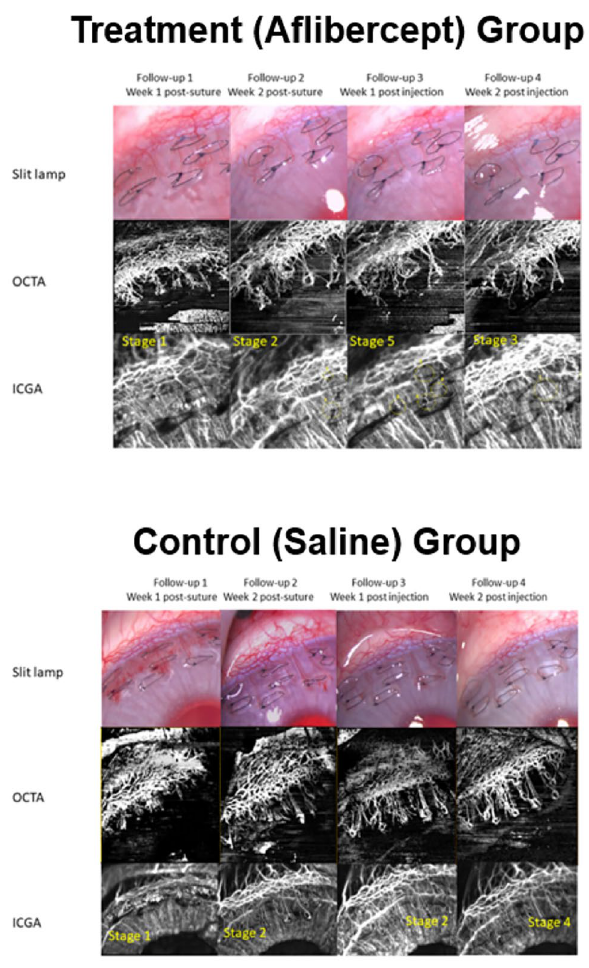
Figure 3. Corneal vascularisation in rabbit eyes before and after receiving subconjunctival aflibercept injections (treatment group) or saline injections (control group). Representative in-vivo slit-lamp photography images (top panels) with their corresponding anterior segment optical coherence tomography angiography (AS-OCTA) images (middle panels) and indocyanine green angiography images (bottom